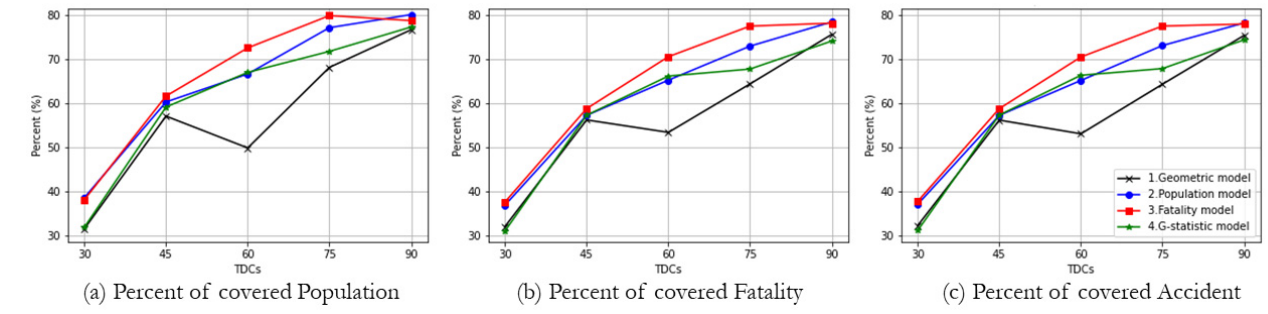
Figure 8. Potential demands under CSAs according to different objectives. ( a ) Percent of covered population; ( b ) Percent of covered fatality; ( c ) Percent of covered accident.